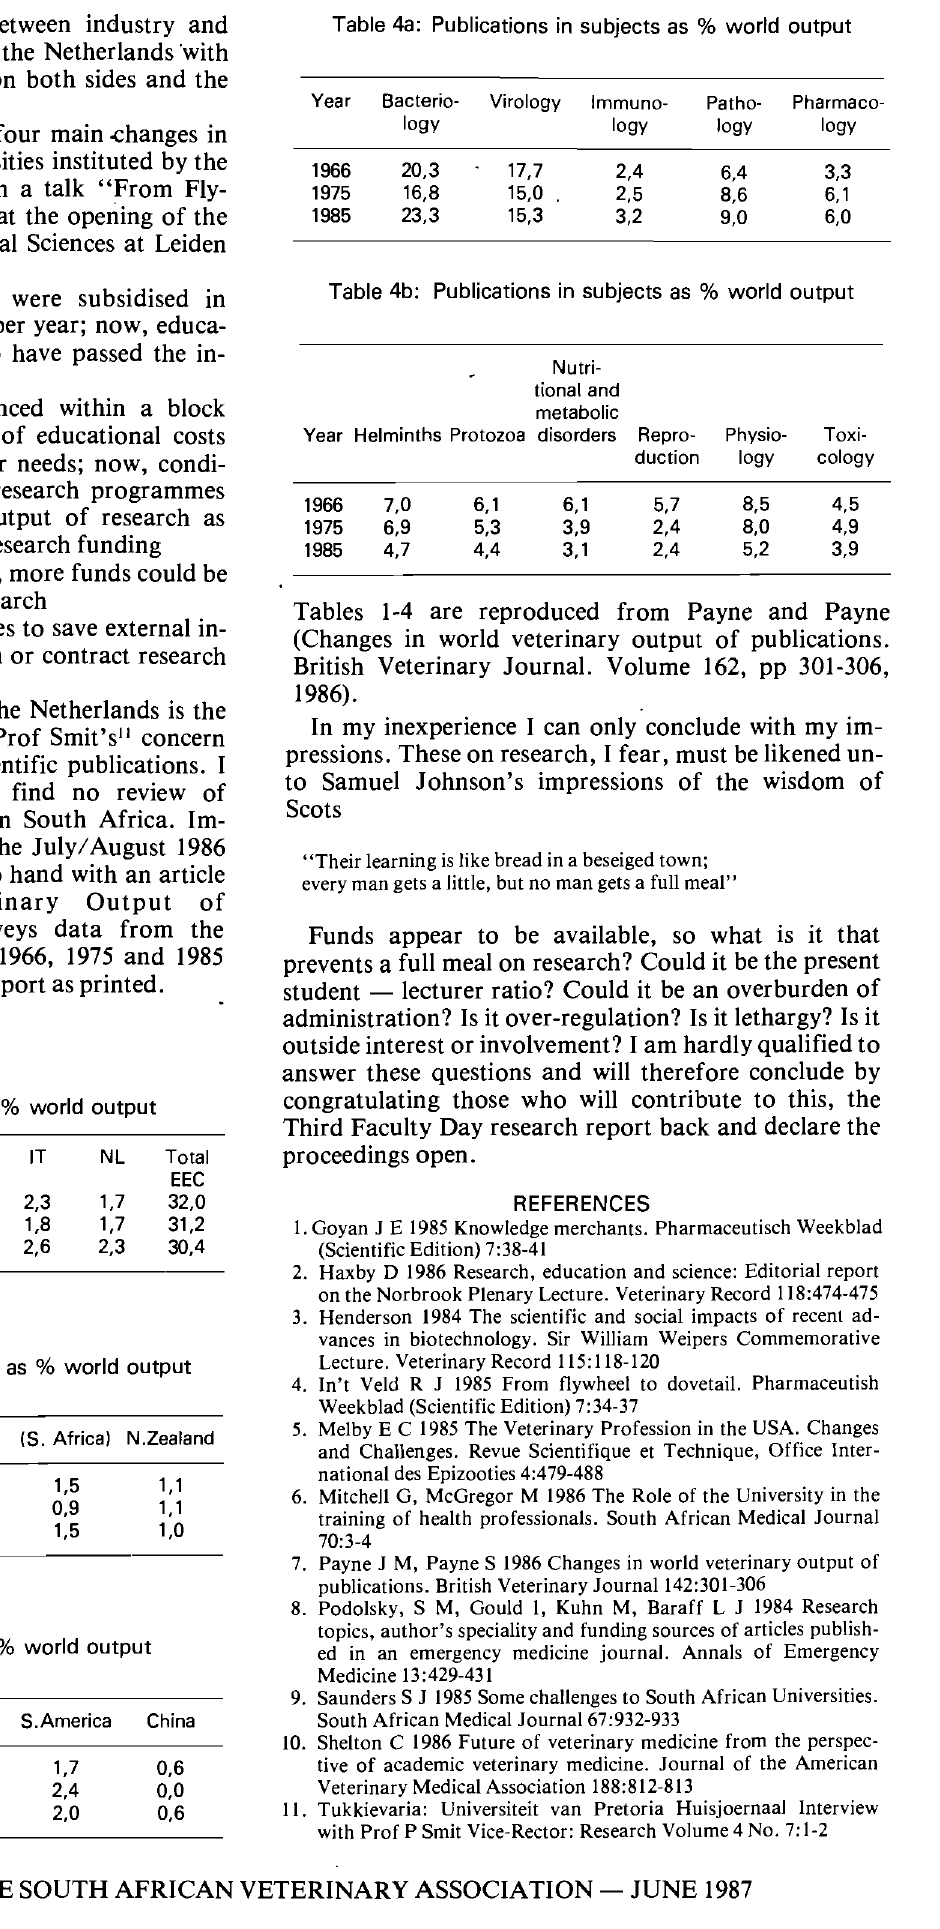
Table 4a: Publications in subjects as % world output